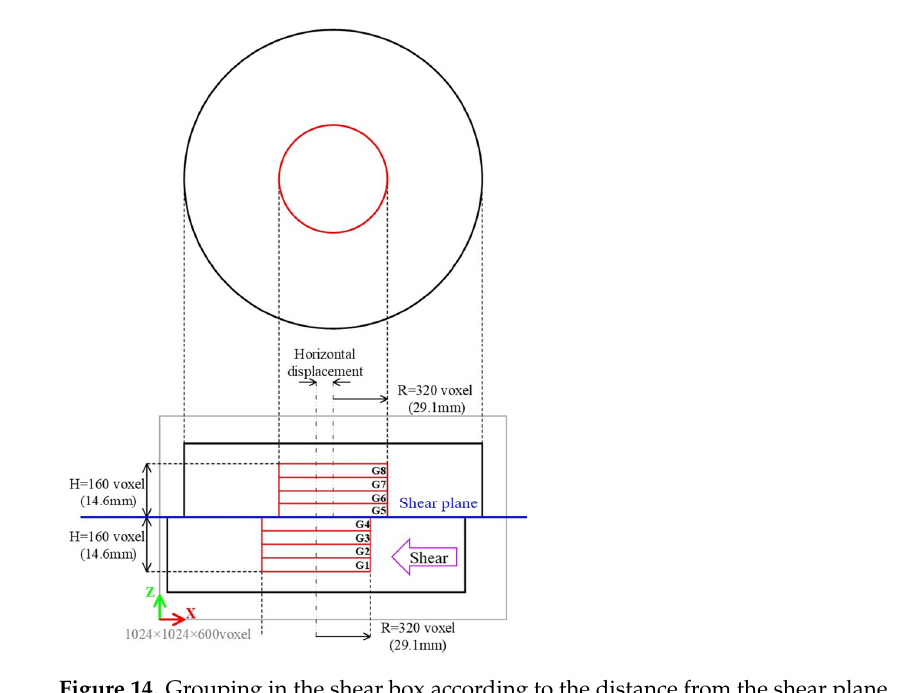
Figure 14. Grouping in the shear box according to the distance from the shear plane.